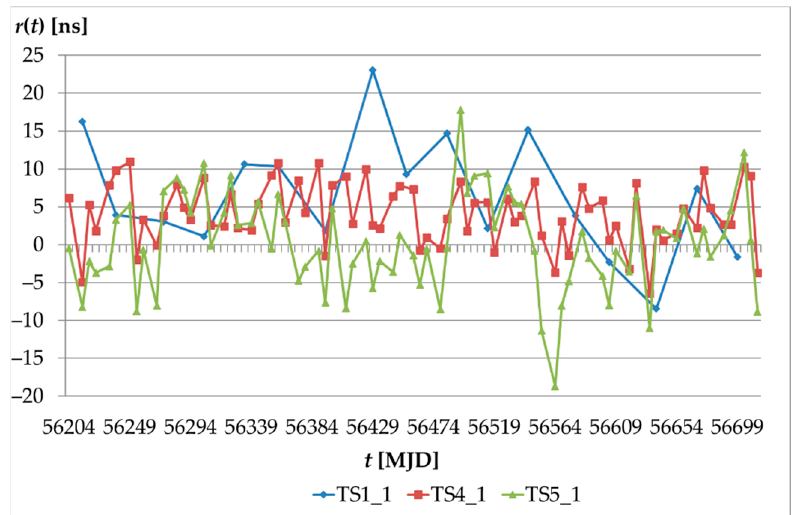
Figure 10. Obtained r residuals values for predicting xb p ( t ) for the TS1_1, TS4_1, and TS5_1.